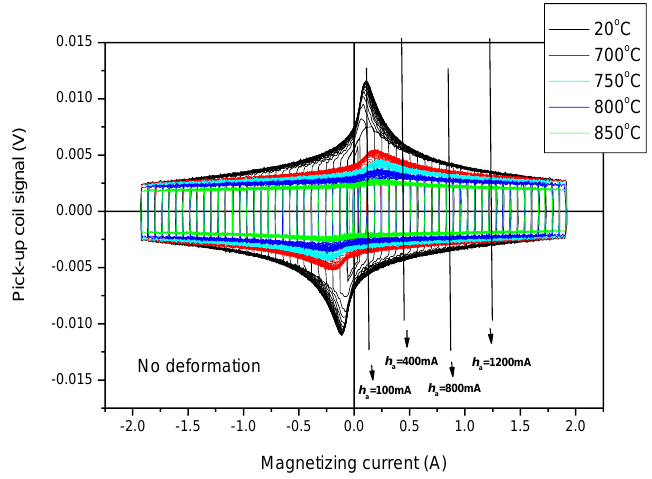
Figure 8. Measured permeability loops of undeformed heat-treated samples. The permeability loops illustrated above were used for calculating the m matrices. Considering that the most visible effect of the heat treatment is in the region where the magnetizing current is around h a = 100 mA (see Figure 8 at the first arrow, which is close to the maximal permeability of samples), h a = 100 mA MAT descriptors were calculated at the beginning. Figure 9 demonstrates how the MAT descriptors ( m matrices) depended on the temperature of the heat treatments of the seven investigated series of samples, if the matrices were calculated using field values of h a = 100 mA and h b = 1300 mA. This MAT parameter offered the largest sensitivity.